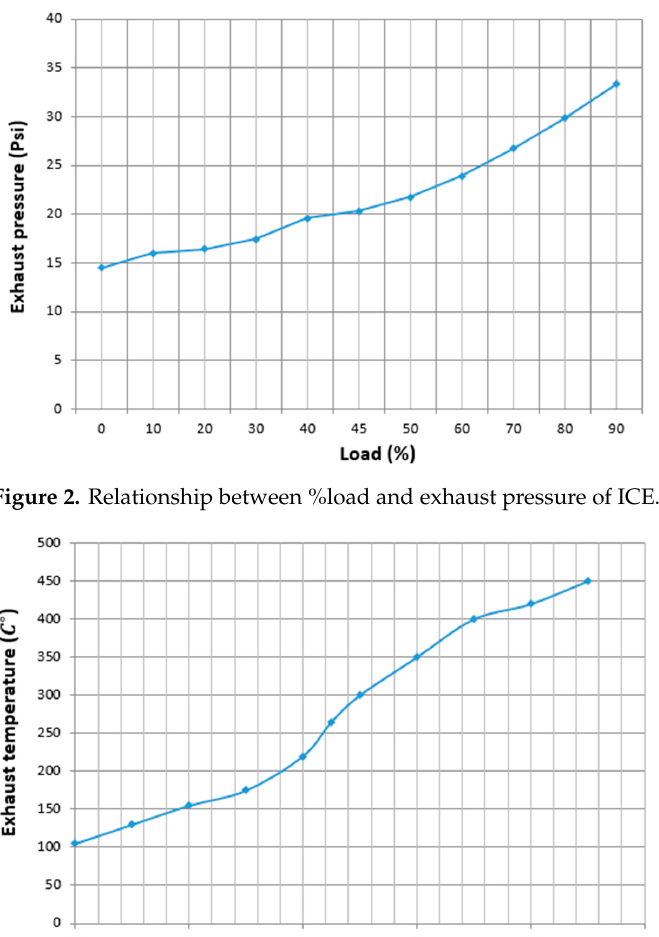
Figure 2. Relationship between %load and exhaust pressure of ICE.